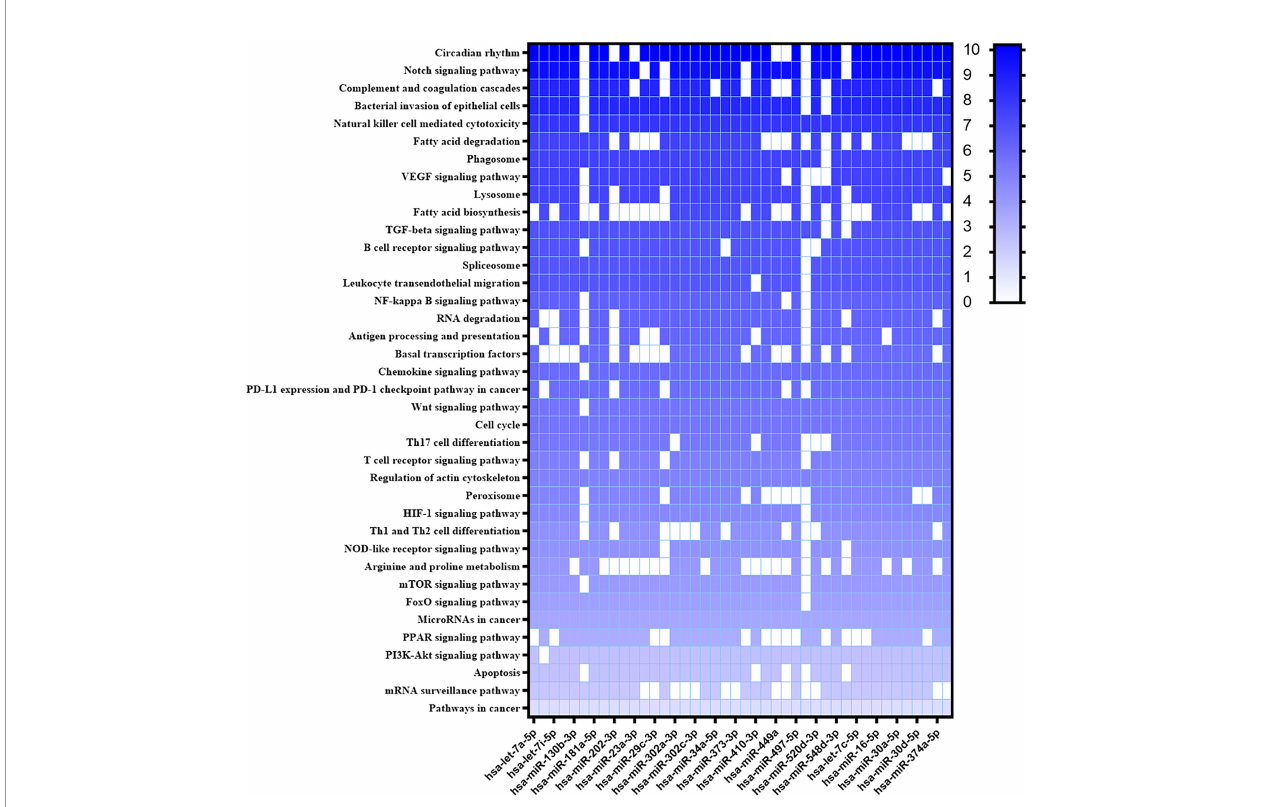
FIGURE 4 | Heatmap of predicted interactions between differentially expressed miRNAs in VL patient plasma. The set of differentially expressed microRNAs in plasma samples from active VL patients caused by L. infantum and the biological pathways on which they are suggested to act according to MiEAA algorithms are shown in heat map format. Results are shown as -log10 of prediction p-value, and the degree of color saturation corresponds to the -log10 of the